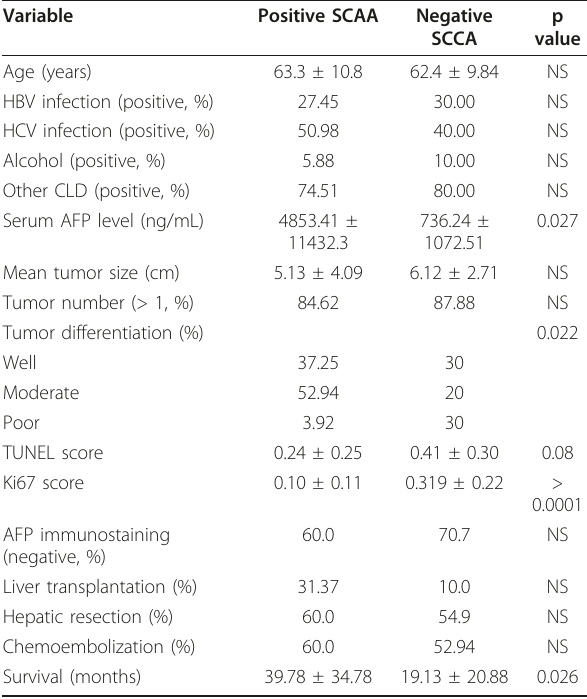
Table 1 Patients ’ baseline characteristics (n = 61) Table 2 Comparison between 2 groups of HCC patients: positive and negative SCCA immunostaining